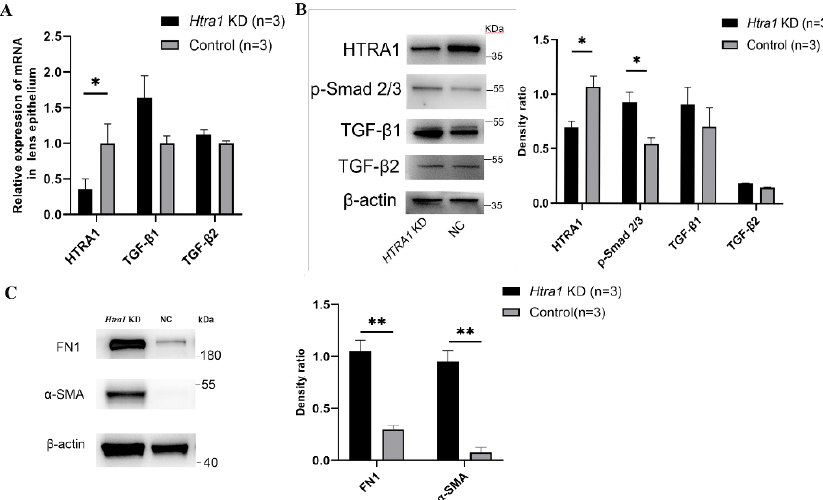
Figure 9. Downregulation of HTRA1 activated the TGF- β/Smad signalling in primary mouse lens epithelial cells. ( A ) Changes of HTRA1, TGF- β1 and TGF - β2 gene expression detected by RT -qPCR (HTRA1 p = 0.045) in primary mouse lens epithelial cells after treatment of HTRA1 knockdown. ( B ) Changes of HTRA1, p-Smad2/3, TGF- β1 and TGF - β2 gene expression detected by Western bl otting (HTRA1 p = 0.029, p-Smad 2/3 p = 0.024) in primary mouse lens epithelial cells after treatment of HTRA1 knockdown. ( C ) The protein levels of FN- 1 and α -SMA in primary mouse lens epithelial cells after treatment of HTRA1 knockdown ( p = 0.002 and 0.002, respectively). * p < 0.05, ** p < 0.01.